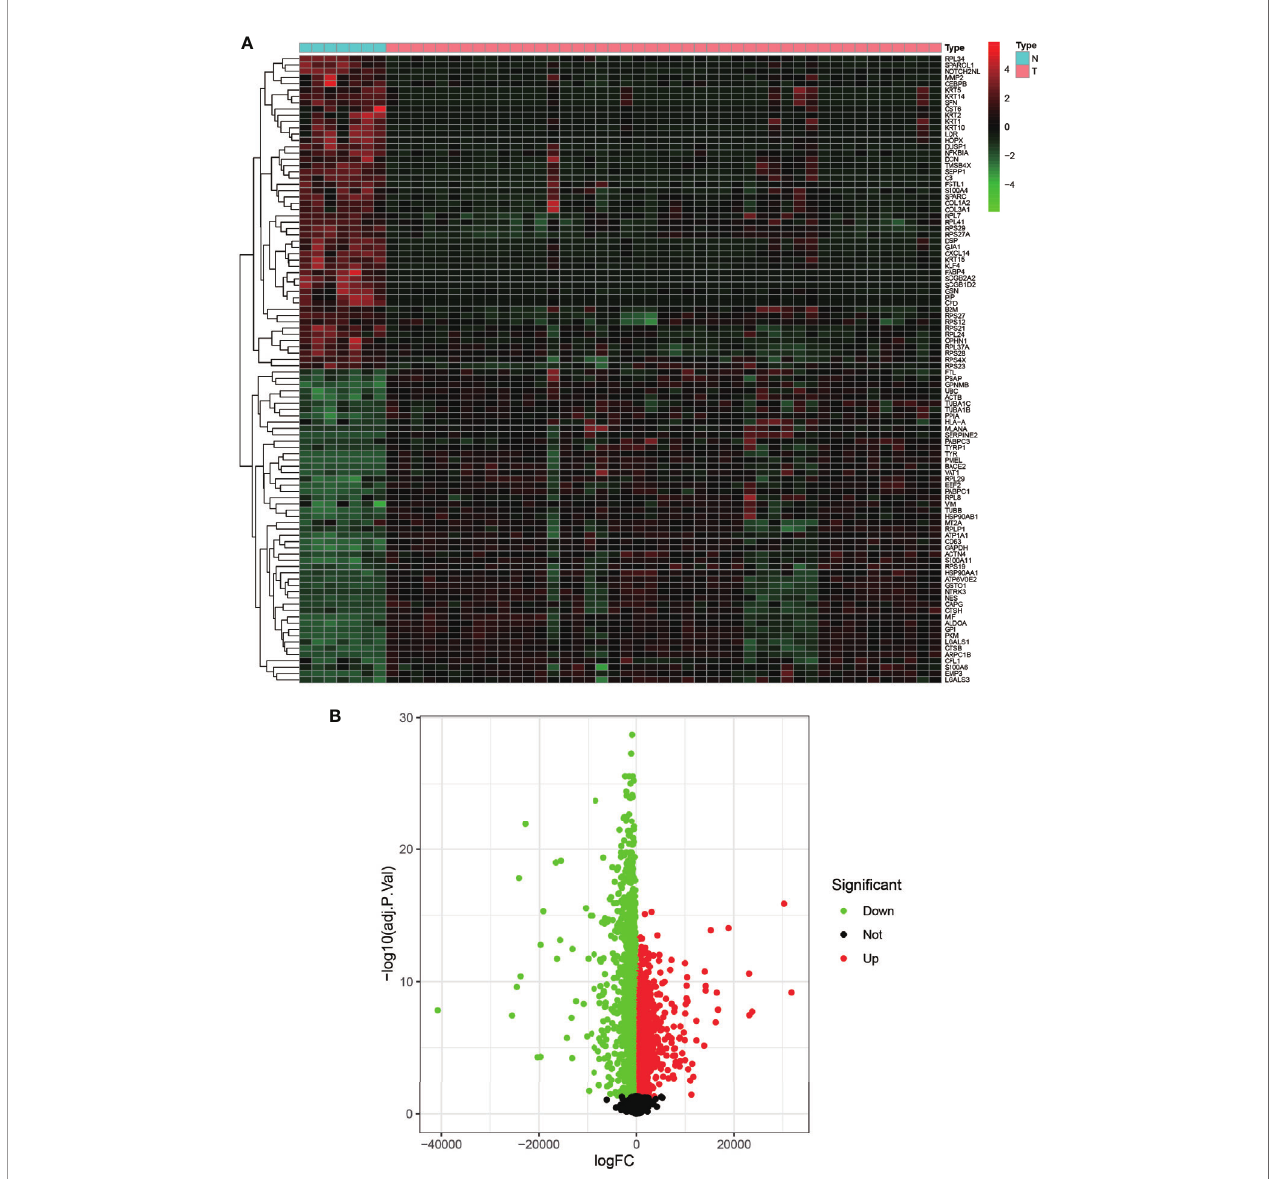
FIGURE 2 | Heat map and volcano map of GSE3189. (A) Heat map of the top 50 upregulated and top 50 down-regulated DEGs obtained from the identi fi cation. The red part indicates upregulated genes, and the green part indicates down-regulated genes. (B) Volcano plot with cut off value set to |logFC|>1,P-value<0.05. Red dots indicate upregulated genes, green dots indicate down-regulated genes, and black represents non-signi fi cant